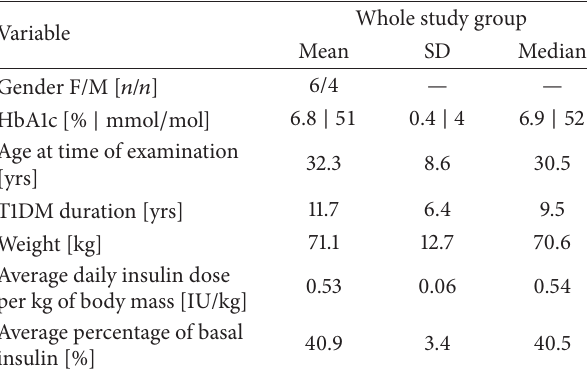
Table 1: Clinical characteristics of study